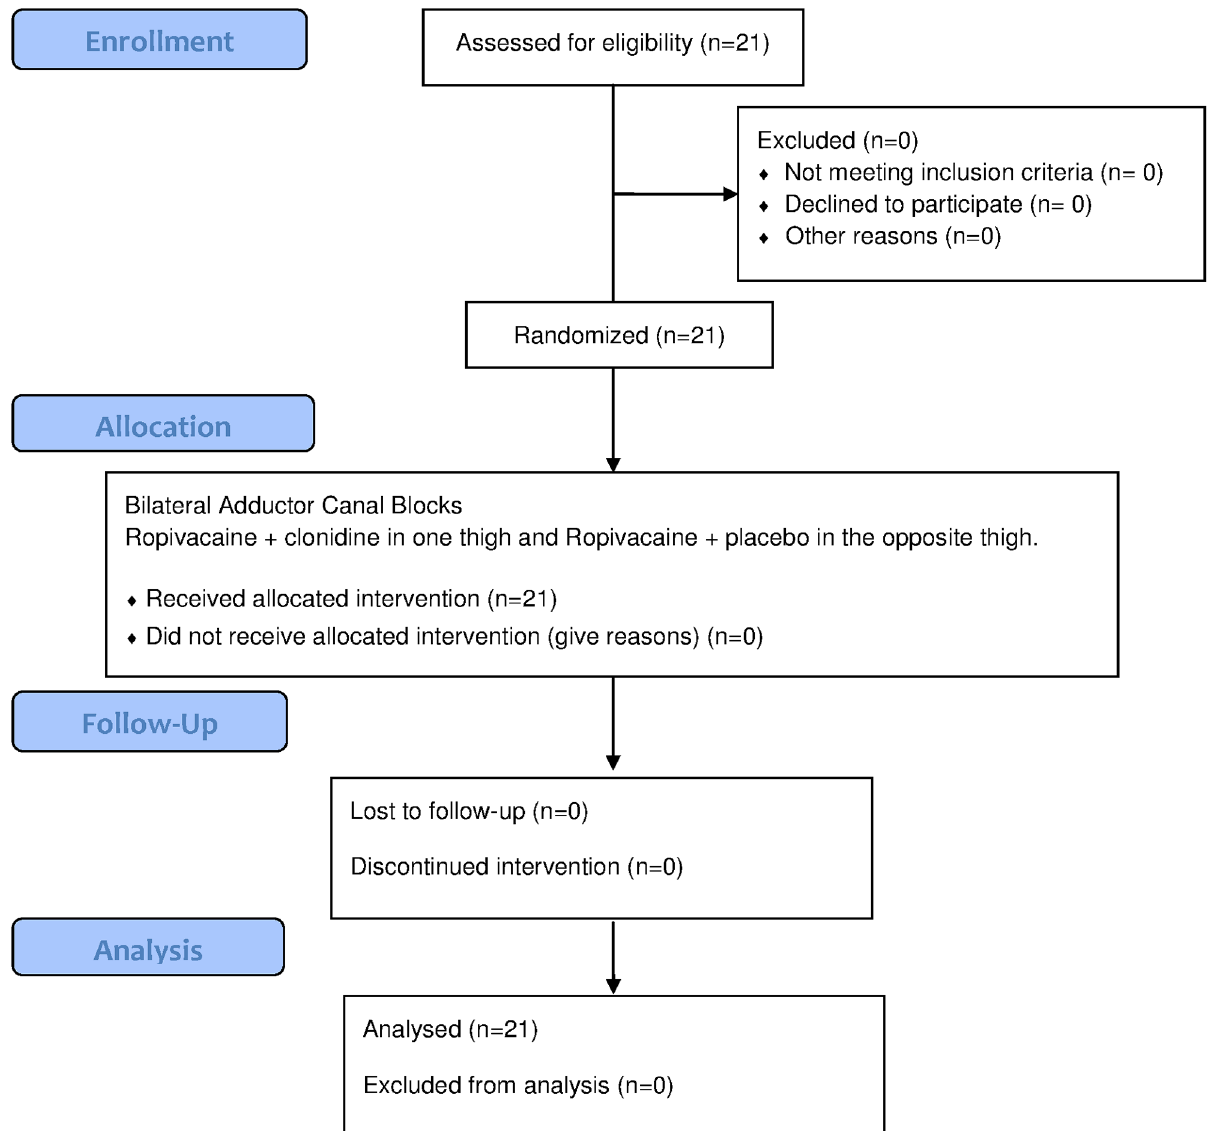
Fig 1. Consolidated Standards of Reporting Trials (CONSORT) flow diagram showing patient progress through the study.